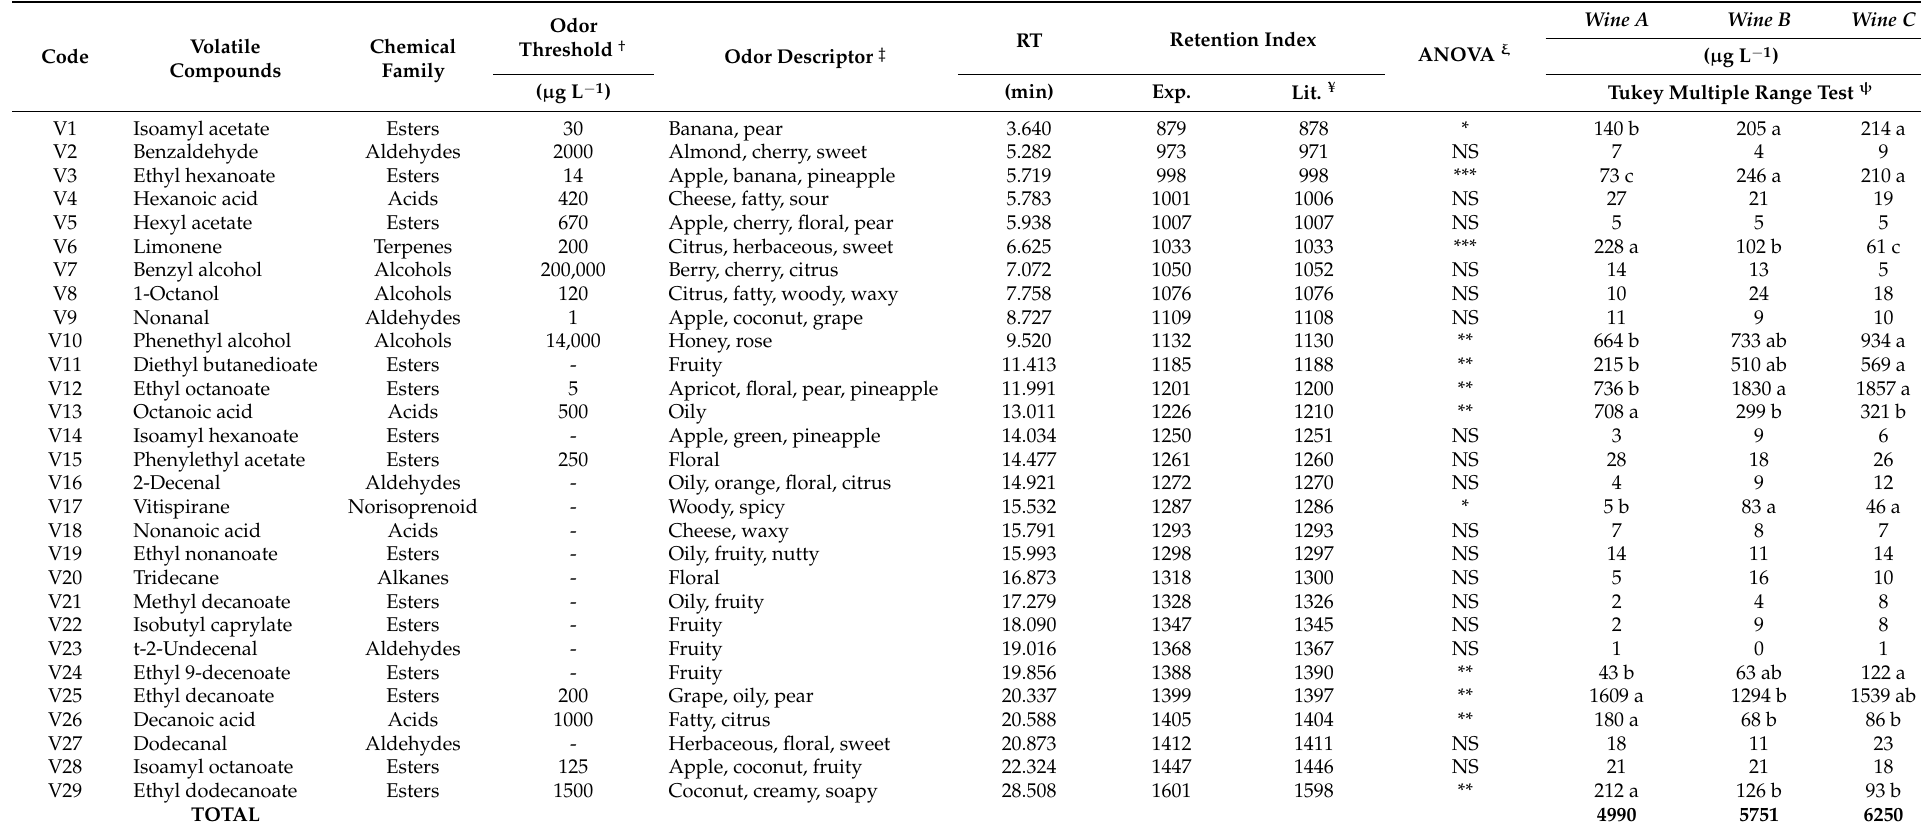
Table 1. Content of volatile compounds ( µ g L − 1 ), retention index and odor descriptors in the studied wines as affected by the type of vessel used for the aging step ( A : aged in clay- tinaja with non-permeable inner coating; B : aged in clay- tinaja without inner coating; C : aged in oak